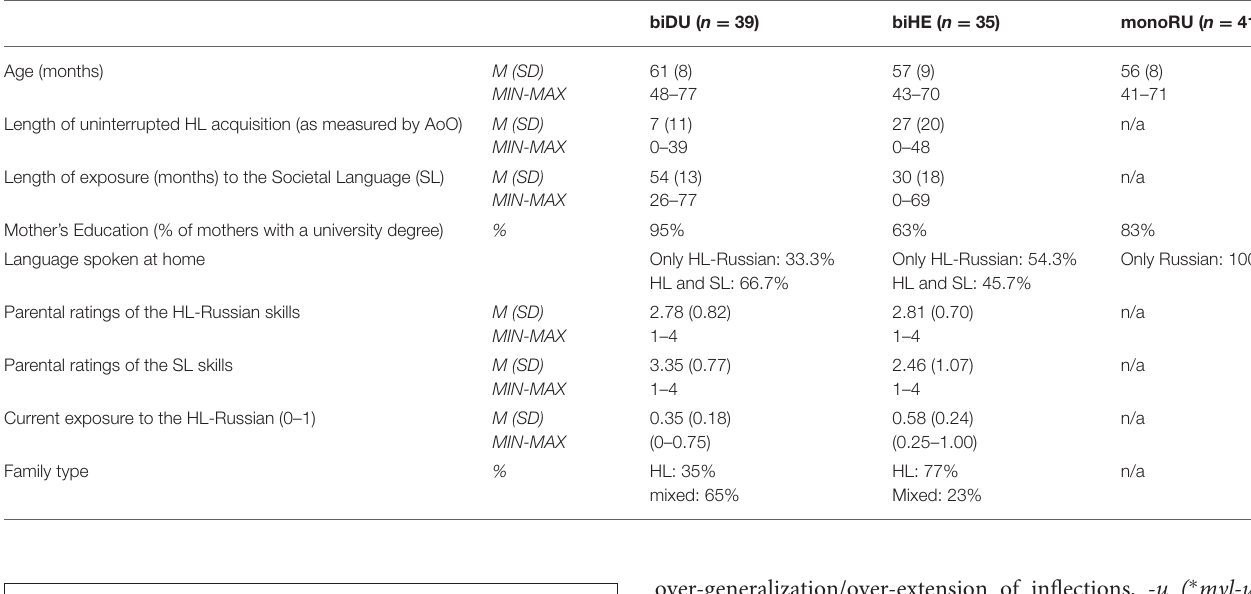
TABLE 2 | Background information on the participants per group.